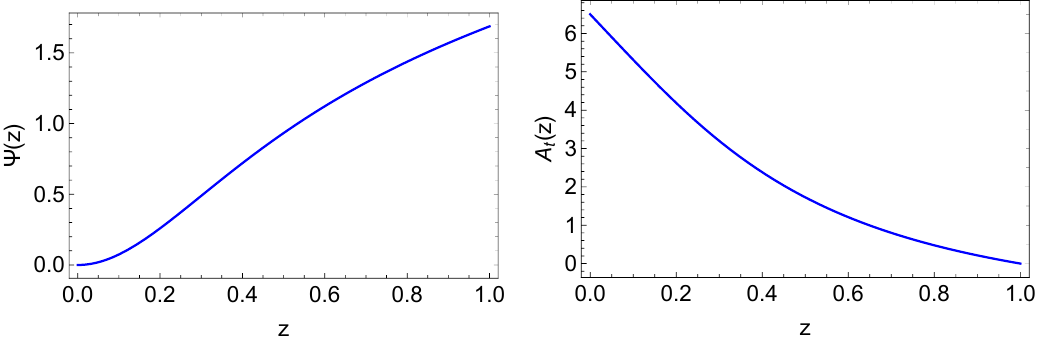
Figure 1 . (cid:9)( z ) and A t ( z ) for (cid:22) = 6 : 5.